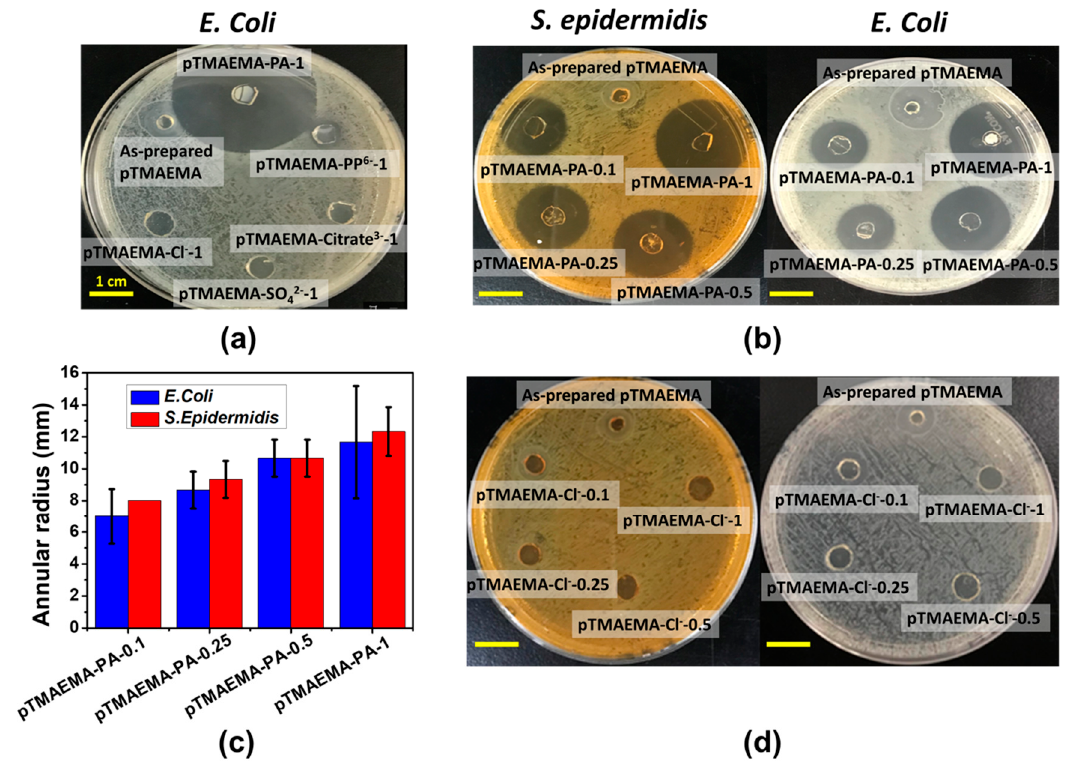
Figure 9. Antibacterial activity of pTMAEMA-PA. ( a ) Antibacterial activity of pTMAEMA-PA-1 in compared with other pTMAEMA-anion hydrogels on E. coli. Loading concentration of electrolyte solution was 1 M. ( b , c ) Concentration-dependent properties of pTMAEMA-PA hydrogels on S. epidermidis and E. coli . ( d ) Control study of antibacterial activity of PA (pTMAEMA-Cl - prepared with 0.1, 0.25, 0.5 and 1 M NaCl solution with adjusted to pH 2).